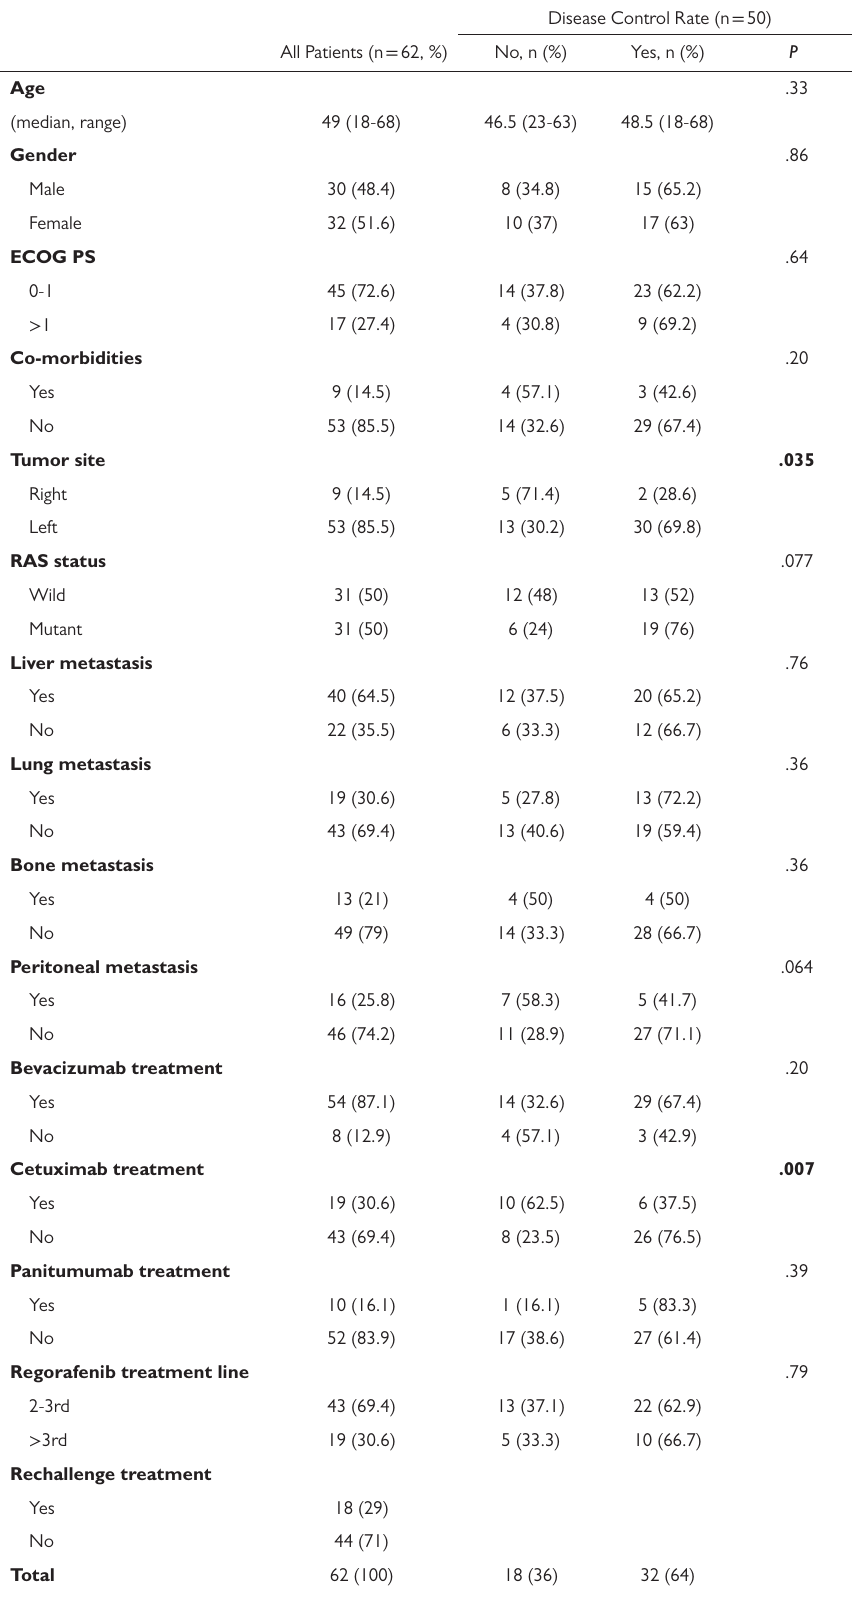
Table 1. Clinical Features of All Patients and Variables Investigated for Disease Control Rate in Patients Who Have Used Regorafenib